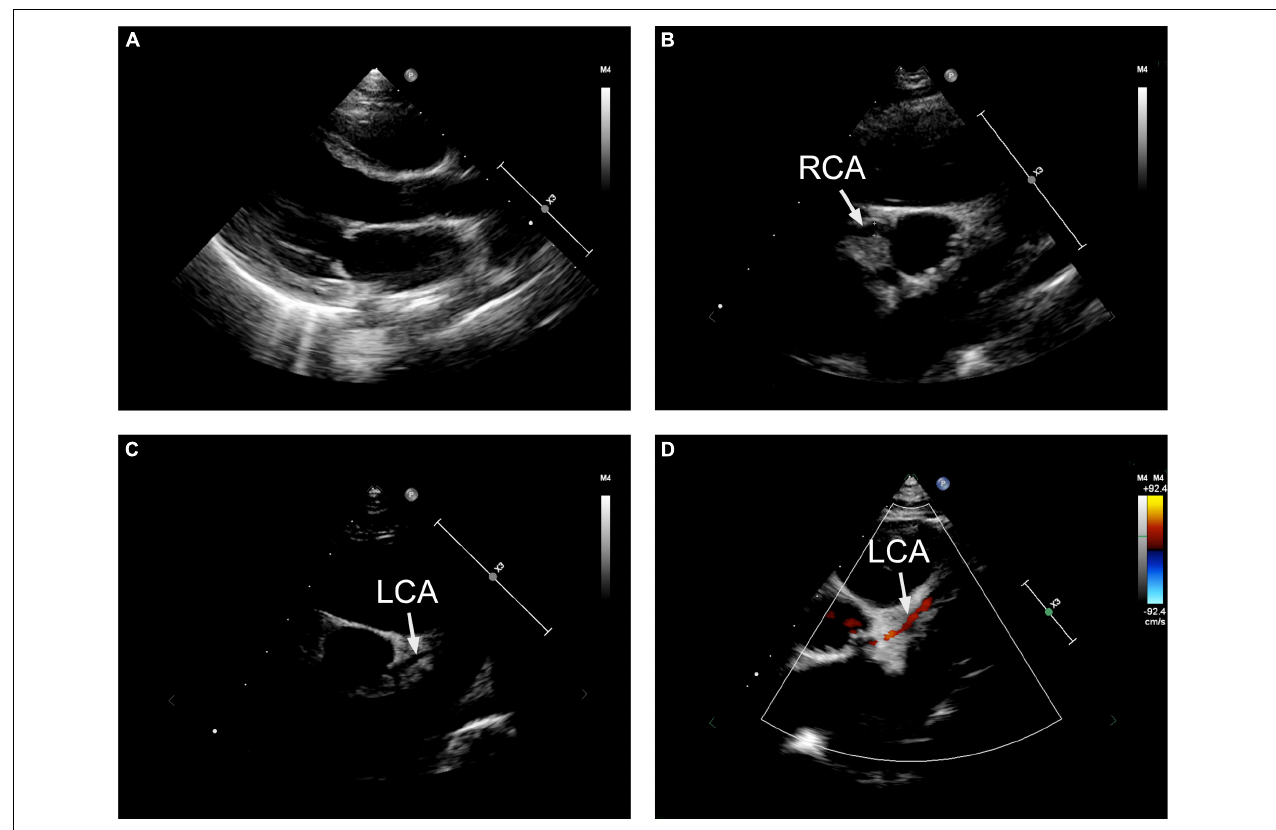
FIGURE 2 | The echocardiographic presentation. (A) Left ventricular ejection fraction (LVEF) decreased dramatically to 23%. (B) The right coronary artery presented clearly with normal formation and lumen diameter. (C) The origin and course of the left coronary artery seemed to be normal, with a related narrowed lumen diameter. (D) Doppler demonstrated a non-continuous blood flow in the left coronary artery. RCA, right coronary artery; LCA, left coronary